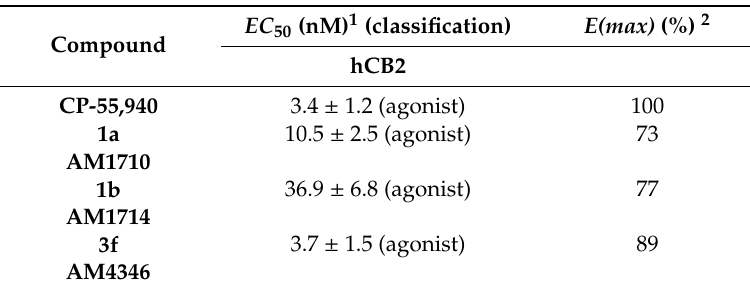
Table 4. Functional potencies (EC 50 ) of key cannabilactones and CP-55,940 for the hCB2 cannabinoid receptor ( ± 95% confidence